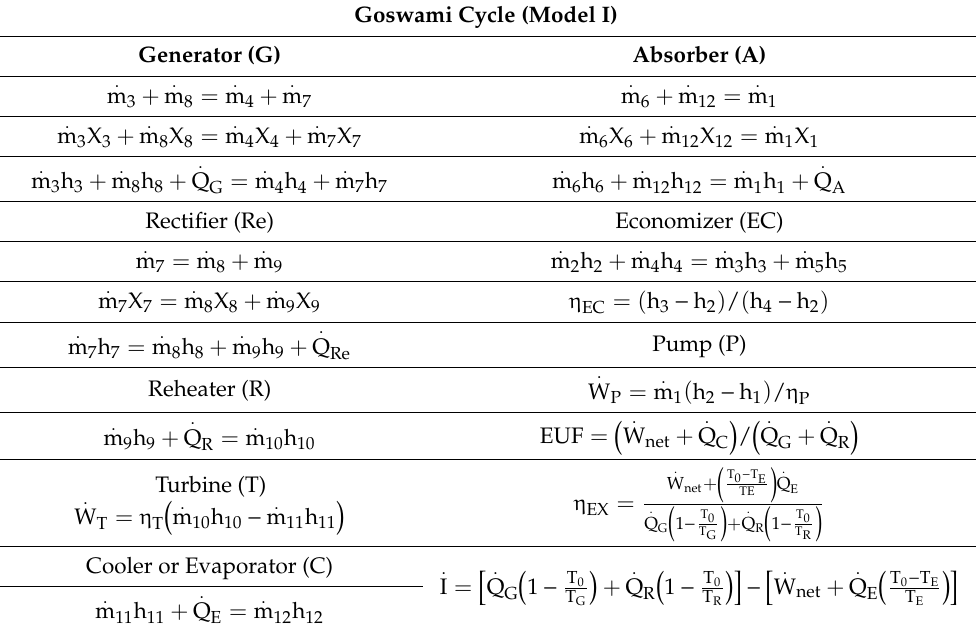
Table 1. Main equations for the Goswami